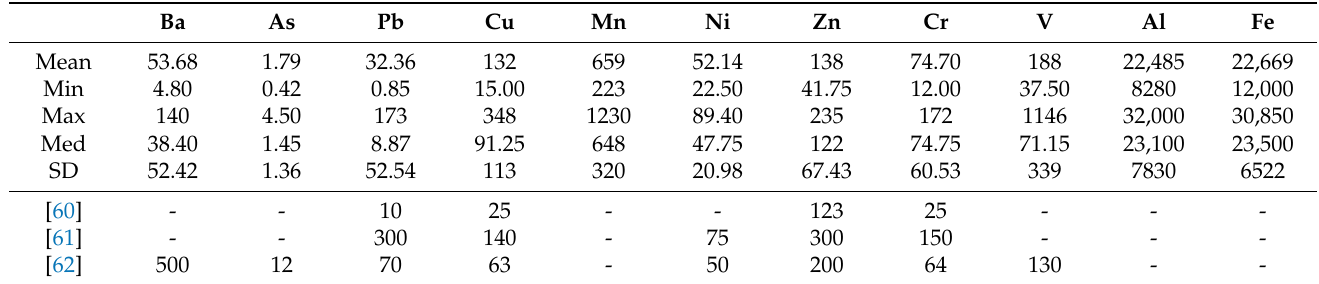
Table 3. Summary statistics of total concentrations of heavy metals (mg/kg) in Bahr El-Baqar drain